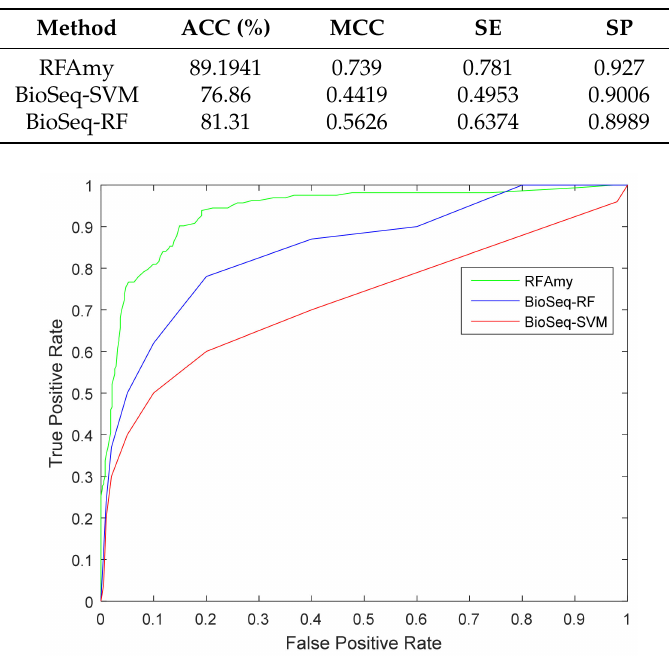
Figure 2. Receiver Operating Characteristic (ROC) curve for RFAmy and two other